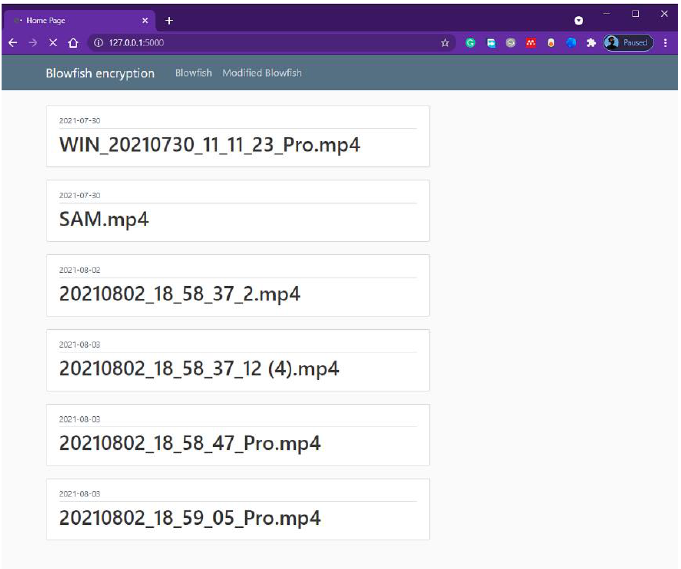
Figure 5. The home page shows the log file register with the file format.